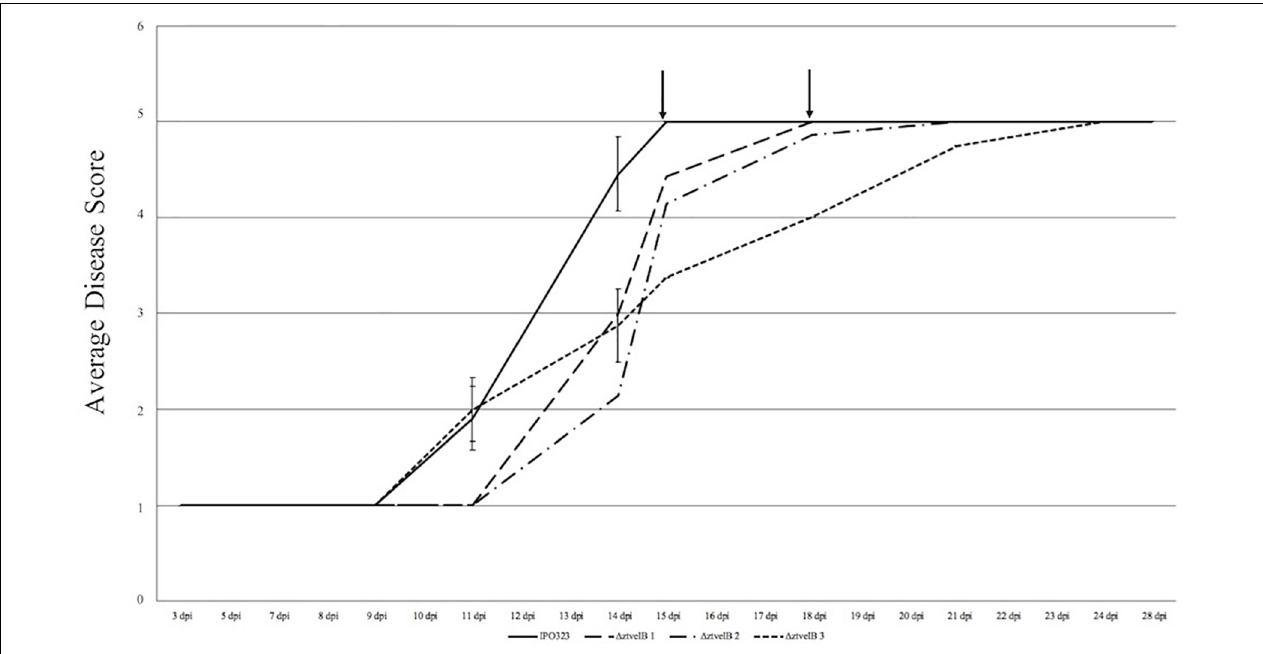
FIGURE 4 | Average timing of Z. tritici infection of the IPO323 strain compared to the (cid:49) ztvelB mutants at 0–28 dpi. Three independent (cid:49) ztvelB strains (dotted lines) were tested against the parental IPO323 strain (straight line), and experiments were repeated in triplicate with 7–12 technical repeats each time. Graph representative of three biological replicates. Wheat leaves (cv. Riband) were inoculated with a plug extracted from a 10-day-old CDV8 agar plate dipped in 0.1% Tween 20. Symptoms were scored on a scale of 1–5 ever 2–3 days. Bars represent standard error and black arrows indicate the point at which the IPO323 strain and first (cid:49) ztvelB strain reached the fifth and final stage of infection. In all three experiments, the IPO323 strain produced symptoms before all three (cid:49) ztvelB